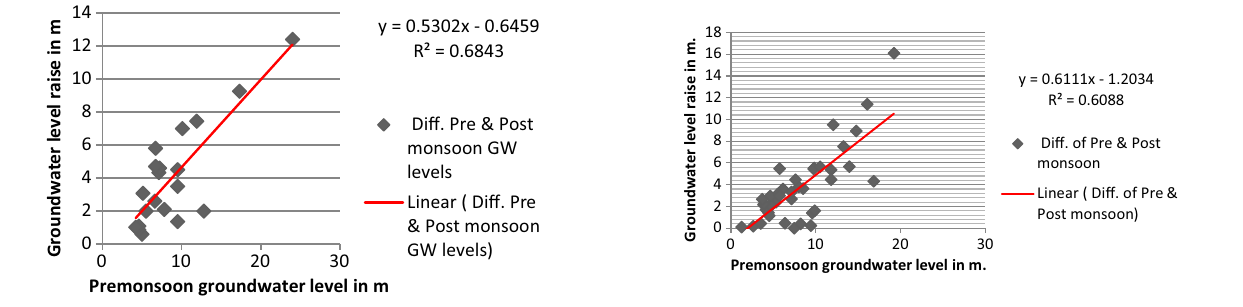
Fig. 9 Relation between pre-monsoon groundwater levels and the dif- ference of pre- and post-monsoon groundwater levels in m in the year